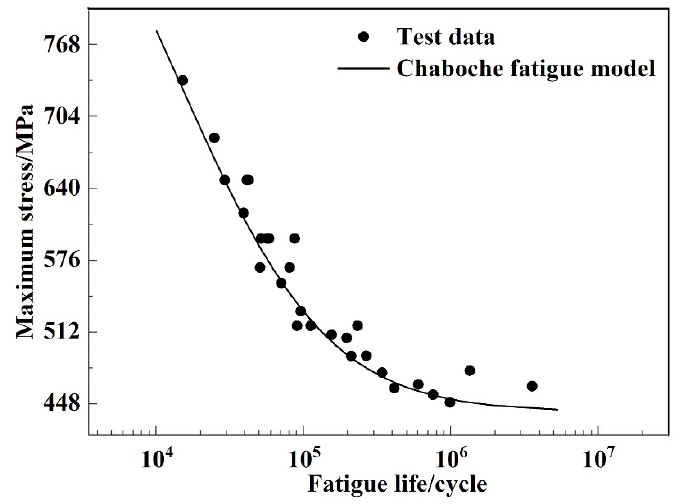
Figure 16. Fatigue test results and fatigue model fitting curve.